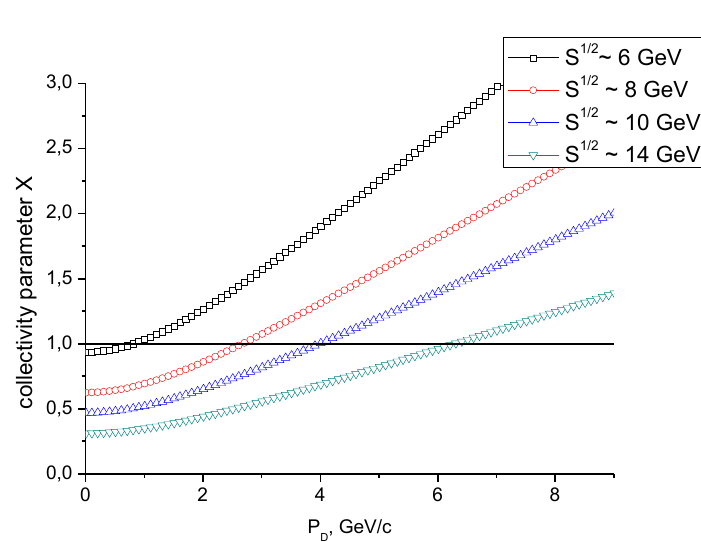
Figure 6. D meson production at 90º in Au -Au